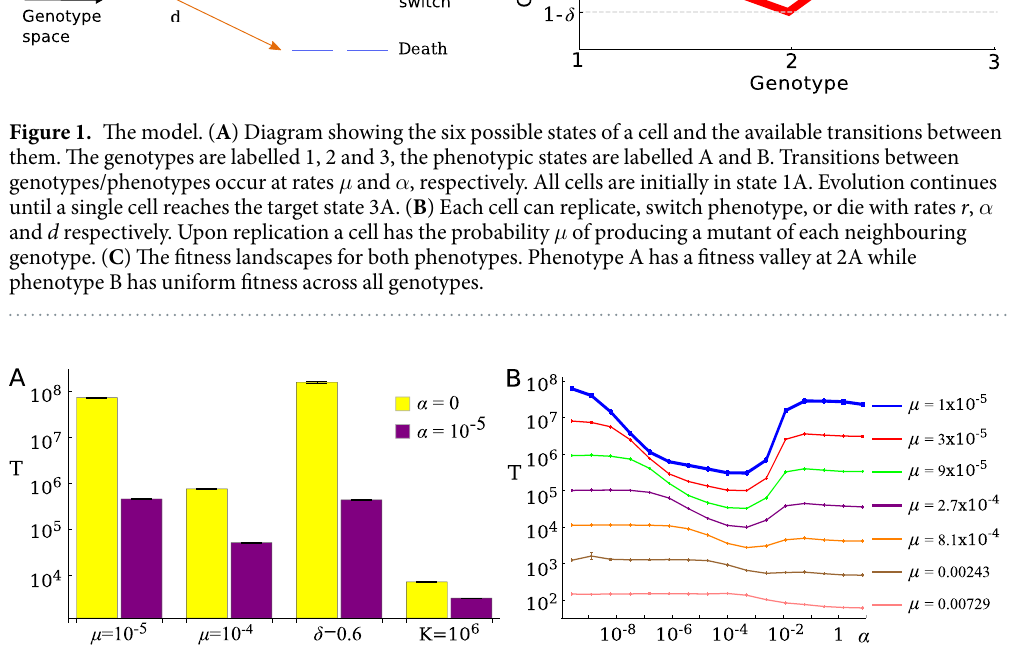
Figure 2. Mean adaptation time T for different scenarios – note logarithmic scale. ( A ) A bar chart comparing pairs of T values with and without switching phenotypes ( α = 10 − 5 and α = 0 respectively) for different parameter values. Left-most pair of bars: K = 100, μ = 10 − 5 , δ = 0.4 and d = 0.1. A label underneath each pair of bars indicates which variable has been changed compared to the left-most pair. ( B ) T as a function of the switching rate α for a range of mutation probabilities μ . Parameters as in (A). For small enough μ an optimal (minimizing T ) switching rate can be